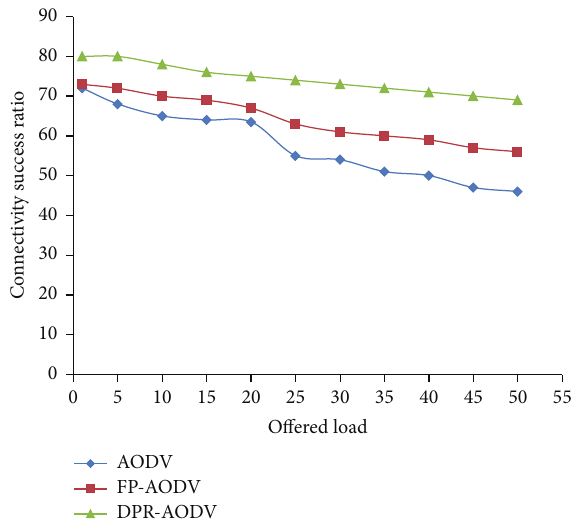
Figure 12: Connectivity success ratio versus offered load.